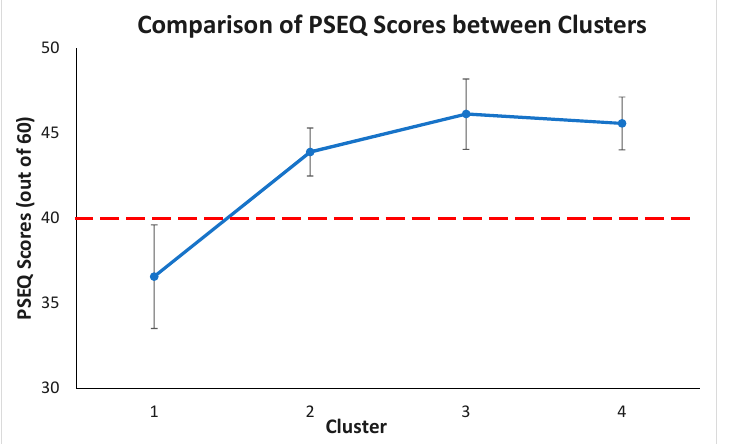
Figure 12. Estimated marginal means of PSEQ between clusters (red dashed line indicates threshold value for PSEQ; below red line suggests clinically significant finding or low pain self-efficacy).